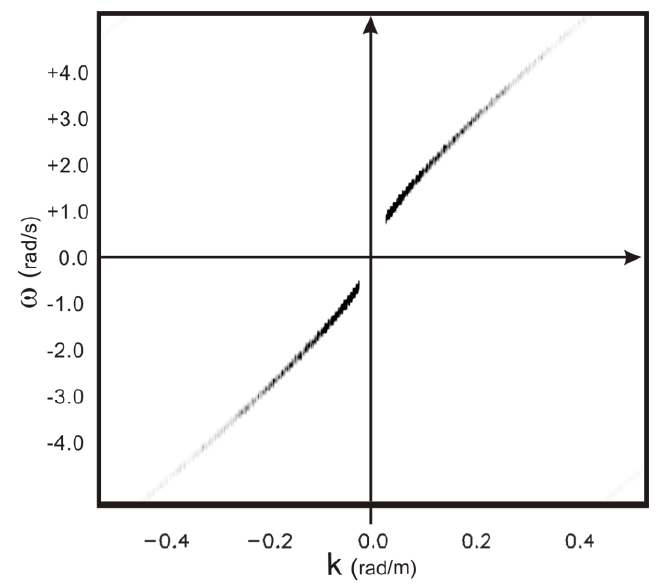
),(  after the MTF and filtering procedure shown in the Figure 12. Wave spectrum   kkF N block diagram of Figure